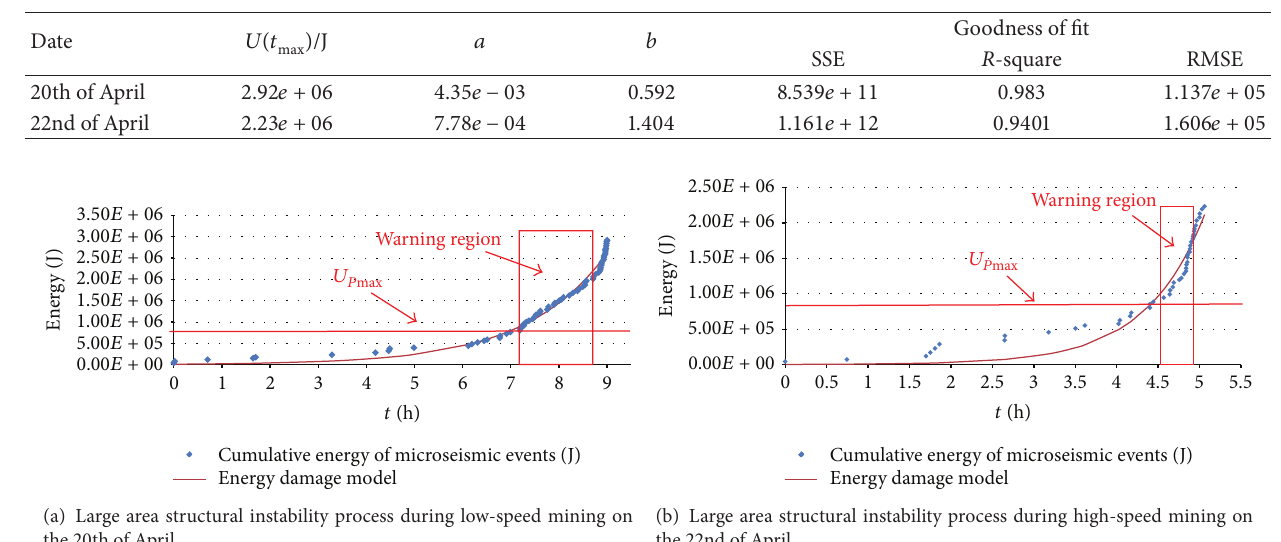
Table 4: Fitting parameters.